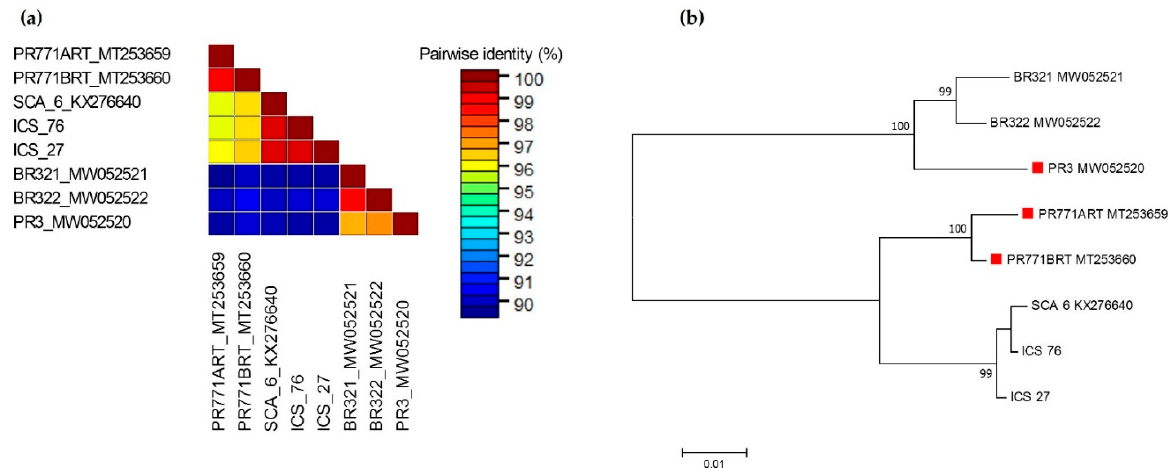
Figure 2. Molecular phylogenetic analyses of eight 861 bp nucleotide sequences of cacao mild mosaic virus (CaMMV) RT-RNase H region obtained in this study (ICS 27; ICS 76), extracted from CaMMV complete genome of isolates from Brazil (BR321 MW052521; BR322 MW052522), Puerto Rico (PR3 MW052520) and Trinidad (SCA 06 KX276640), and CaMMV polyprotein gene, partial cds of isolates from Puerto Rico (PR771ART MT253659; PR771BRT MT253660). ( a ) Pairwise comparisons were conducted using Sequence Demarcation Tool version 1.2 [21] ( b ) The evolutionary history was inferred by MEGA7 [22] by using the Maximum Likelihood method based on the Kimura 2-parameter model [23]. The percentage of trees in which the associated taxa clustered together is shown next to the branches. A discrete Gamma distribution was used to model evolutionary rate differences among sites. The tree is drawn to scale, with branch lengths measured in the number of substitutions per site. Red square before taxa names represent CaMMV isolates identified from RIM 52 accession in Puerto Rico.